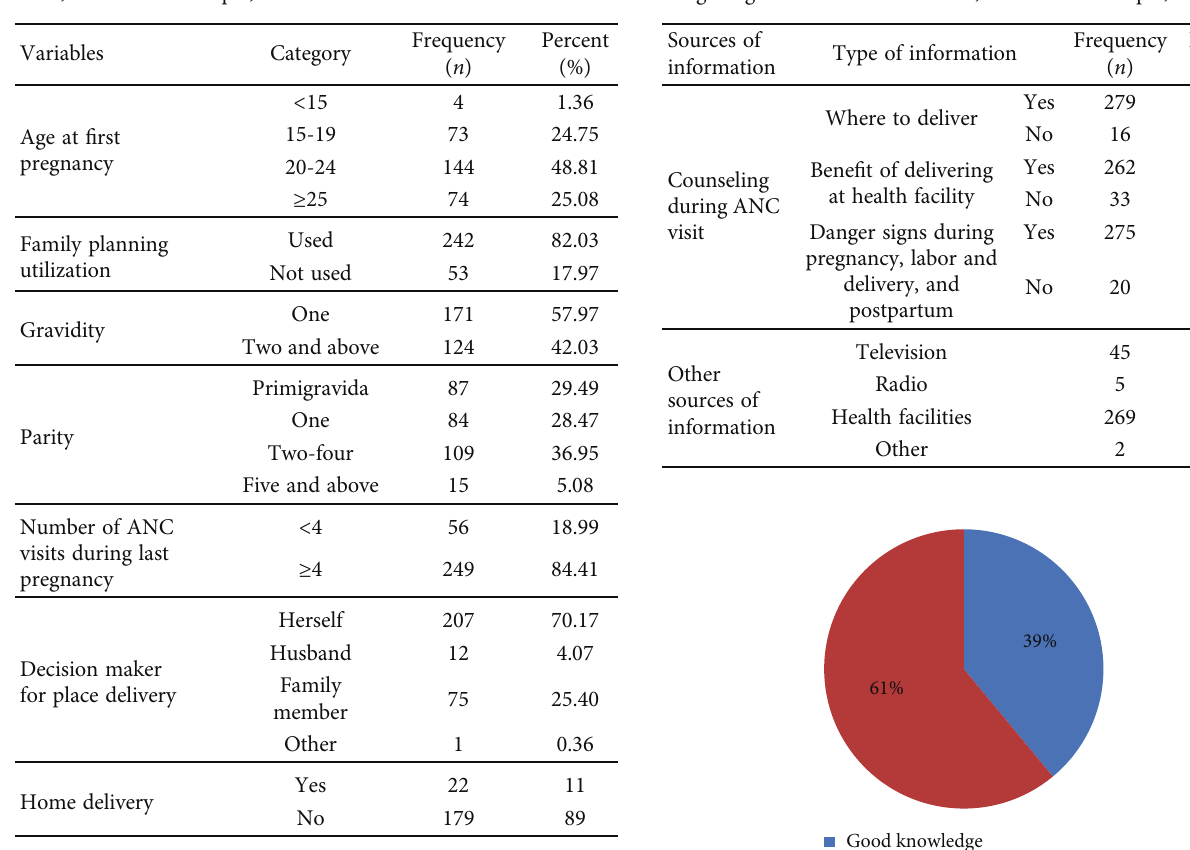
Table 4: Source of information on pregnant women about obstetric danger signs in Debre Tabor town, Northwest Ethiopia, 2021.